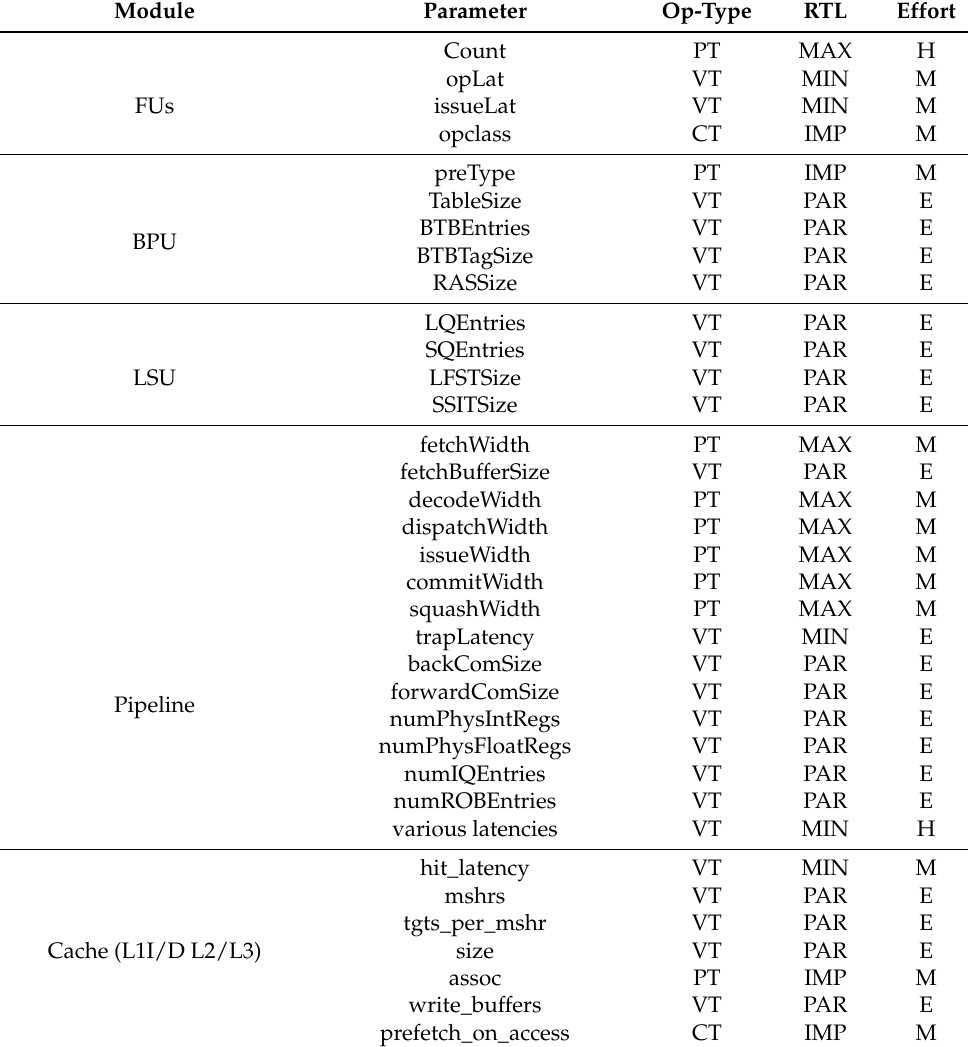
Table 2. Categorization consideration of design options from GEM5 (VT: value type; PT: policy type; CT: choice type. PAR: parameter; MIN: minimal; MAX: maximum; IMP: implementation. E: easy; M: medium; H: